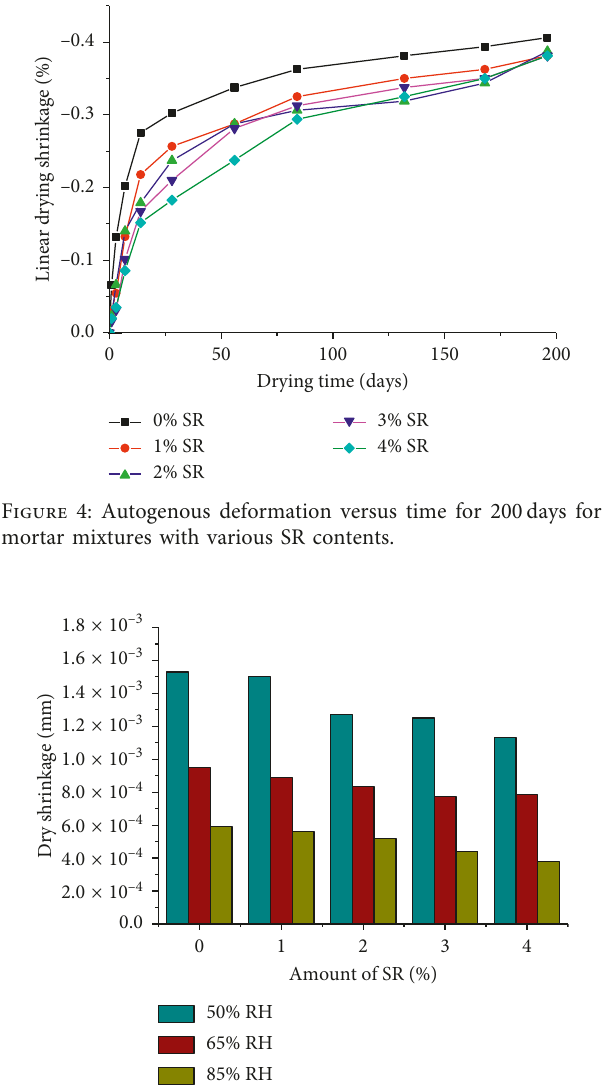
Figure 5: Dry shrinkage value of concrete with various SR contents at